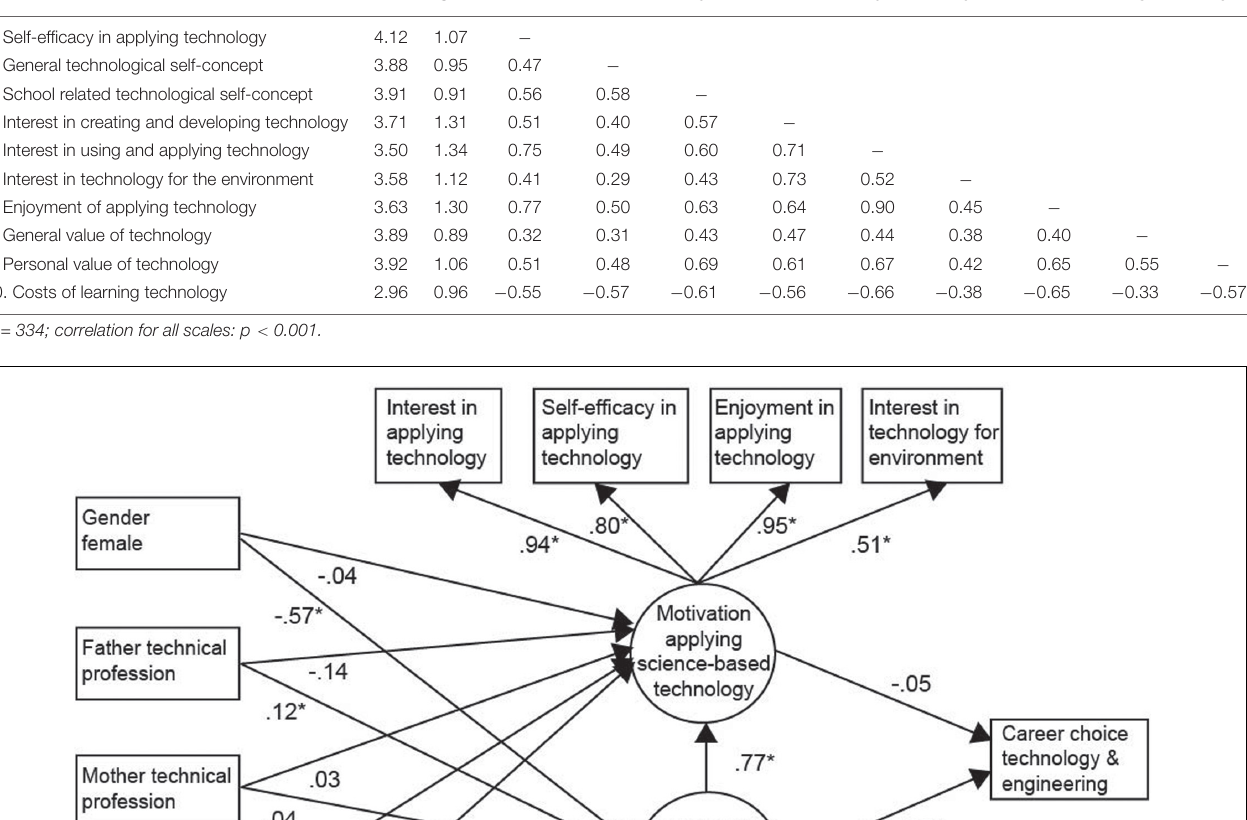
TABLE 1 | Descriptive statistics and correlations of students’ attitudes toward science-based technology. M SD 1